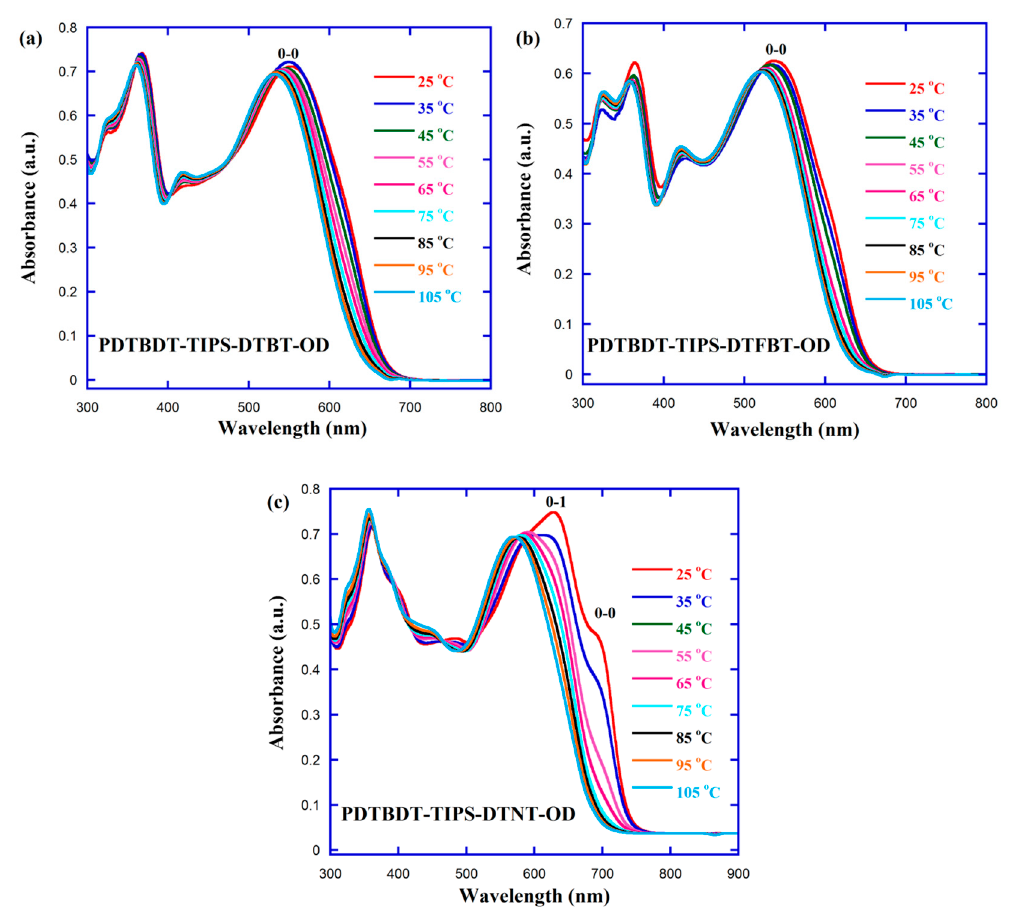
Figure 3. TD-Abs spectra for polymers in the CB with the concentration of approximately 10 − 5 mol L − 1 (temperature ranged from 105 to 25 °C with a 10 °C interval).